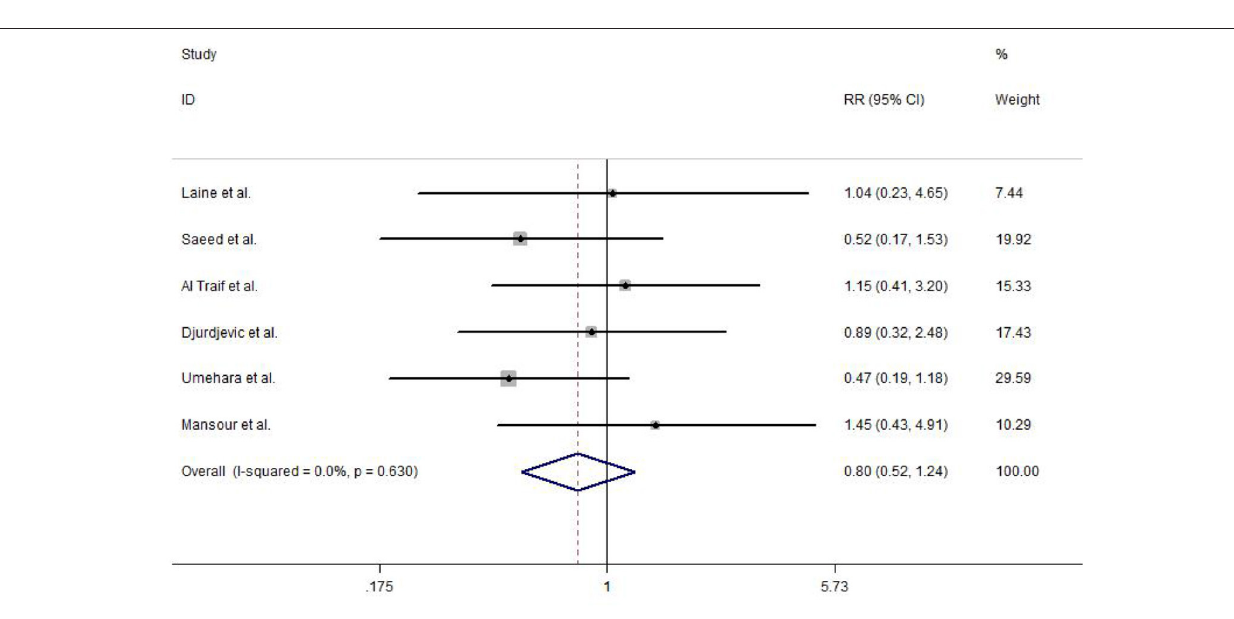
FIGURE 7 | Forest plot of the meta-analysis comparing EVL and EVL + EIS in overall mortality. EIS, endoscopic injection sclerotherapy; EVL, endoscopic variceal